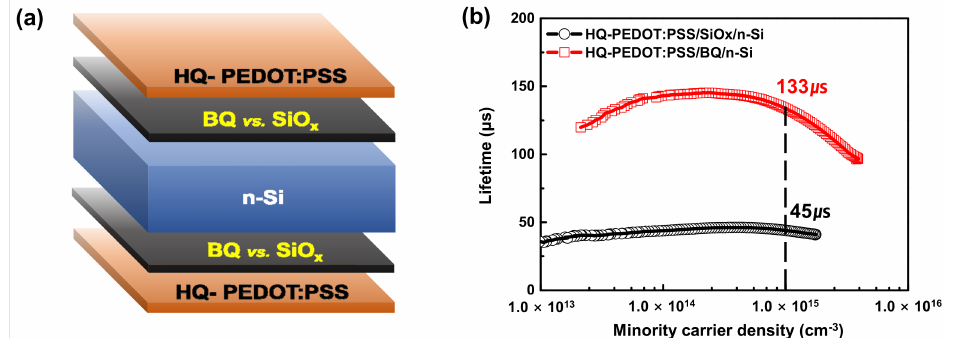
Figure 9. ( a ) The structure used to measure the lifetime and ( b ) carrier injection-dependent lifetime of HQ-PEDOT:PSS on silicon wafers with the different surface passivation layers.